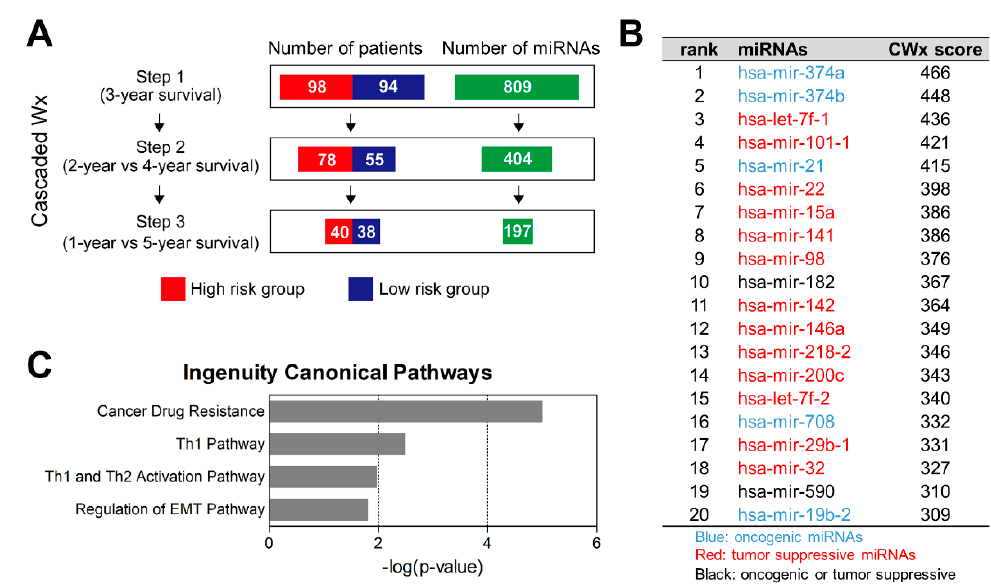
Figure 1. The CWx platform predicts miRNA features associated with lung adenocarcinomas (LUAD) patient survival. ( A ) Overview of the CWx miRNA-selection procedure. The number of samples (patients) was reduced through three cascading processes involving di ff erent criteria. Di ff erent cut-o ff s (3-year, 2- vs. 4-year, and 1- vs. 5-year) were used to categorize samples into high- or low-risk classes at the first, second, and the final steps, respectively. Additionally, the number of input miRNAs was reduced by ~50% at each step according to the prognostic potential (CWx score) of given miRNAs. ( B ) List of the CWx-miRNAs. The top 20 miRNAs predicted through the CWx platform are listed in the table along with their CWx scores. ( C ) IPA of the CWx miRNAs. CWx miRNAs ( n = 197) were analyzed using the IPA tool to estimate enriched canonical pathways. Significantly enriched pathways ( p < 0.05) are presented in the graph.